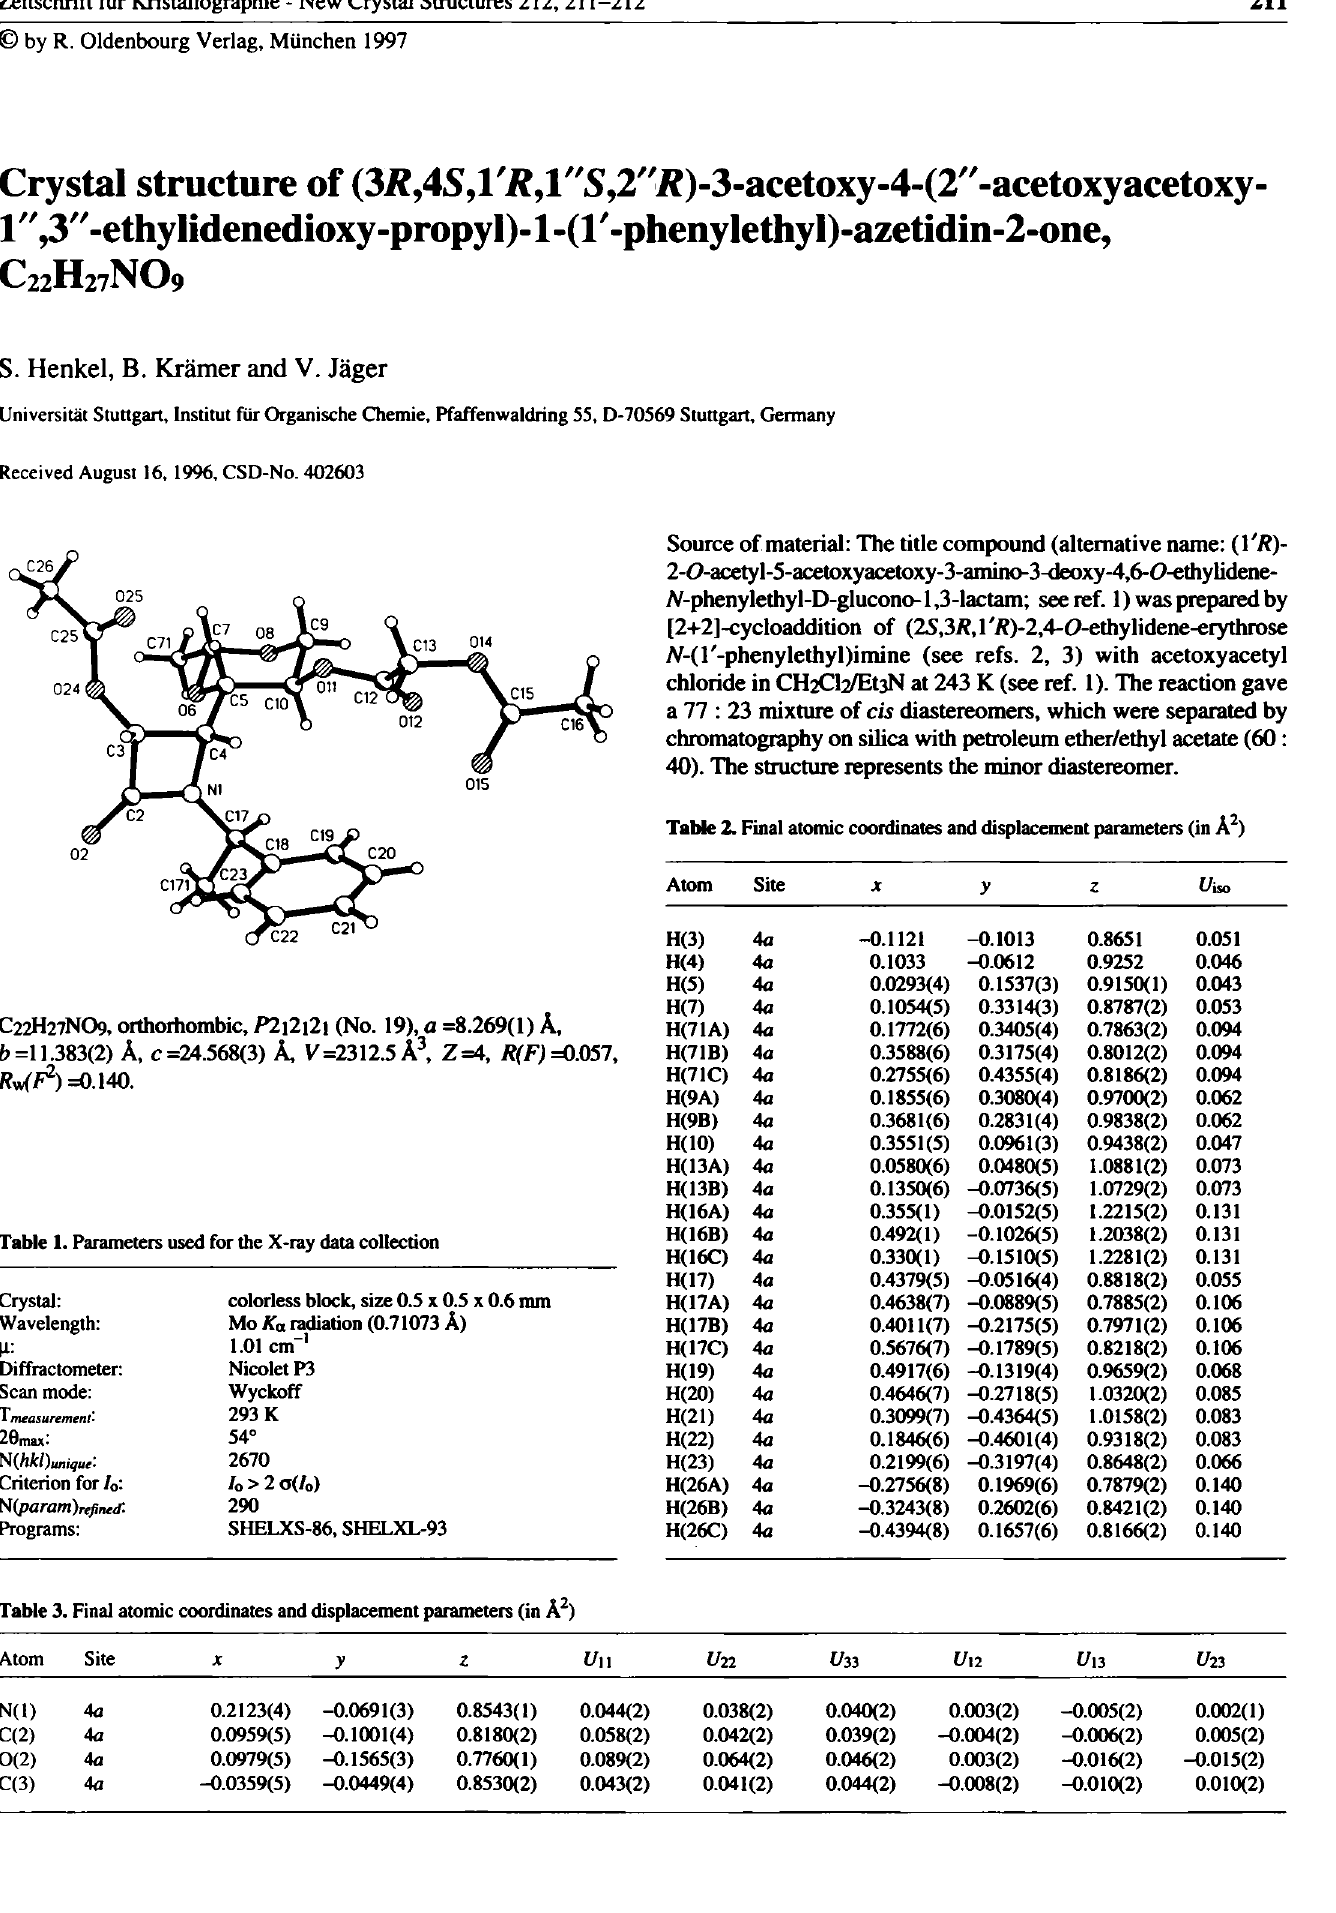
Table 1. Parameters used for the X-ray data collection Crystal: